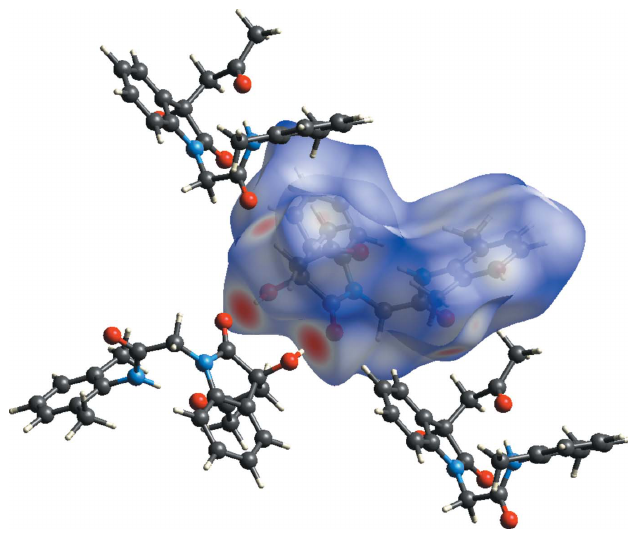
Figure 4 The Hirshfeld surface for the title molecule with three close neighbors added.